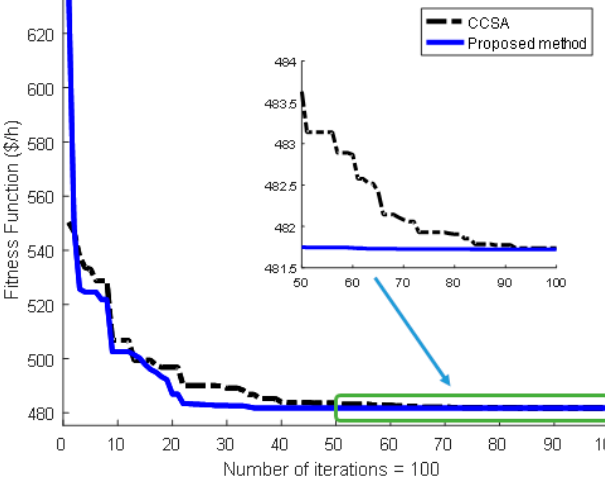
Figure 3. Fitness function curves iteration obtained by the CCSA and proposed method for sub-case 1.1.